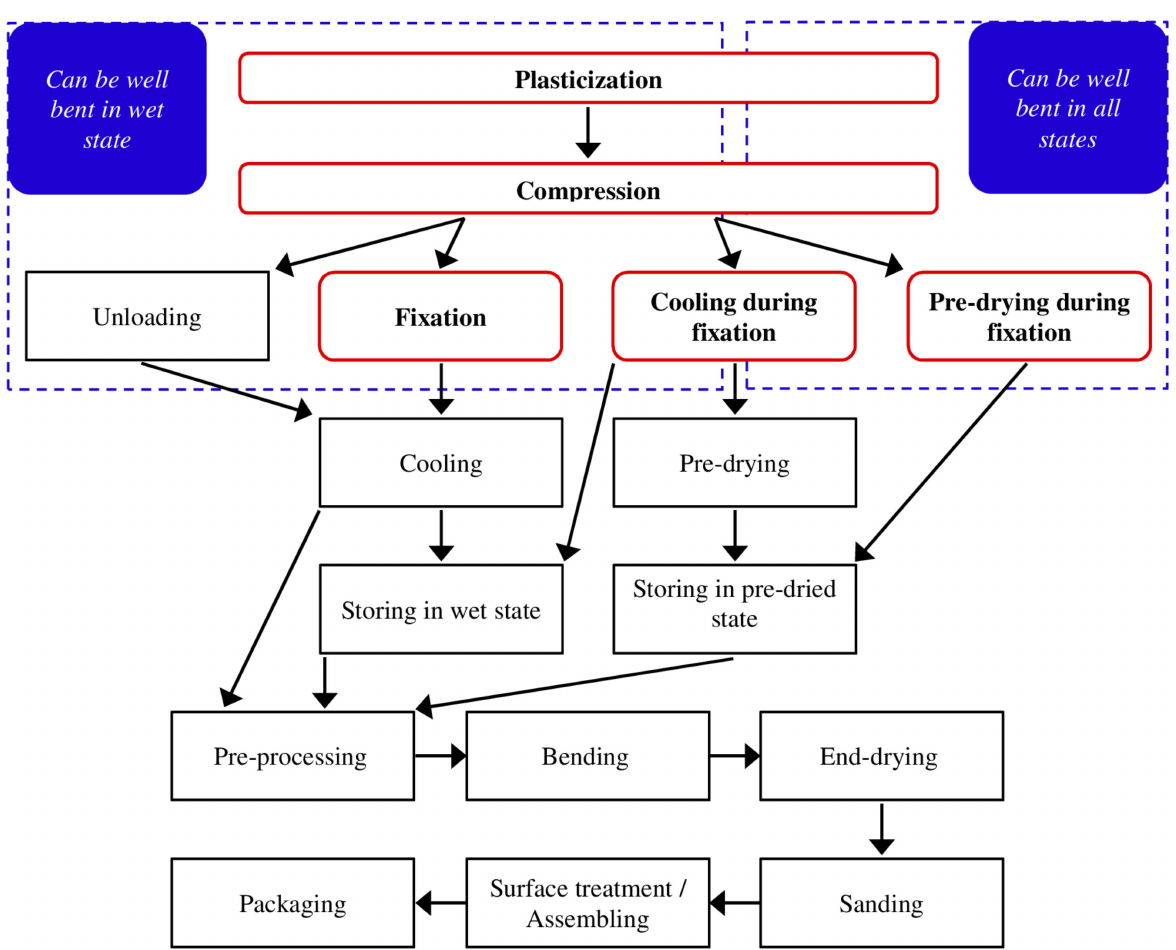
Figure 7. Posttreatment processes after pleating in use today. Reproduced from [59], with permission from B á der, 2023. The three main steps (plasticization, compression, and fixations) are highlighted using red boxes and bold